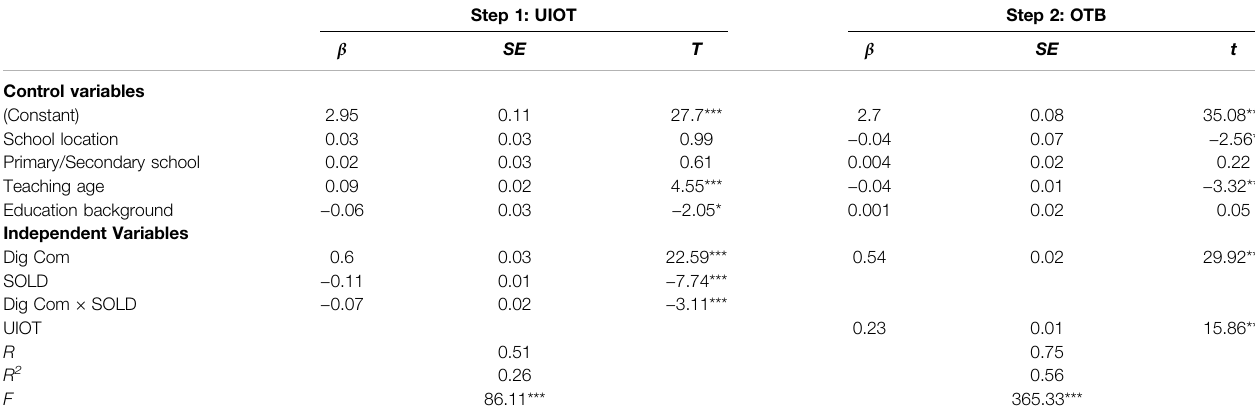
TABLE 3 | Analysis of use intention of online teaching, digital competence, and online teaching behavior, students ’ online learning dif fi culties.